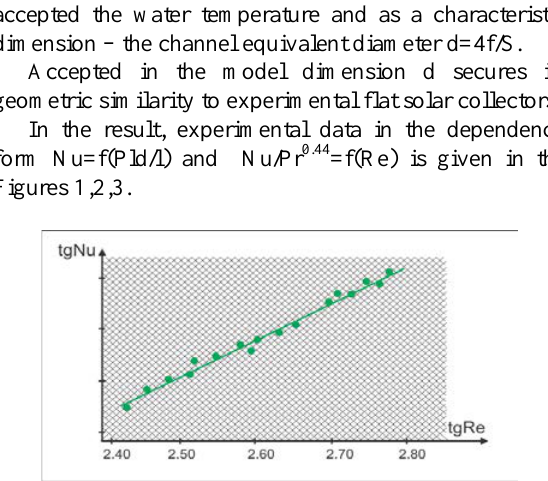
Figure 3. Nusselt criterion dependence on Reynolds criterion for liquid flow in the flat solar collector